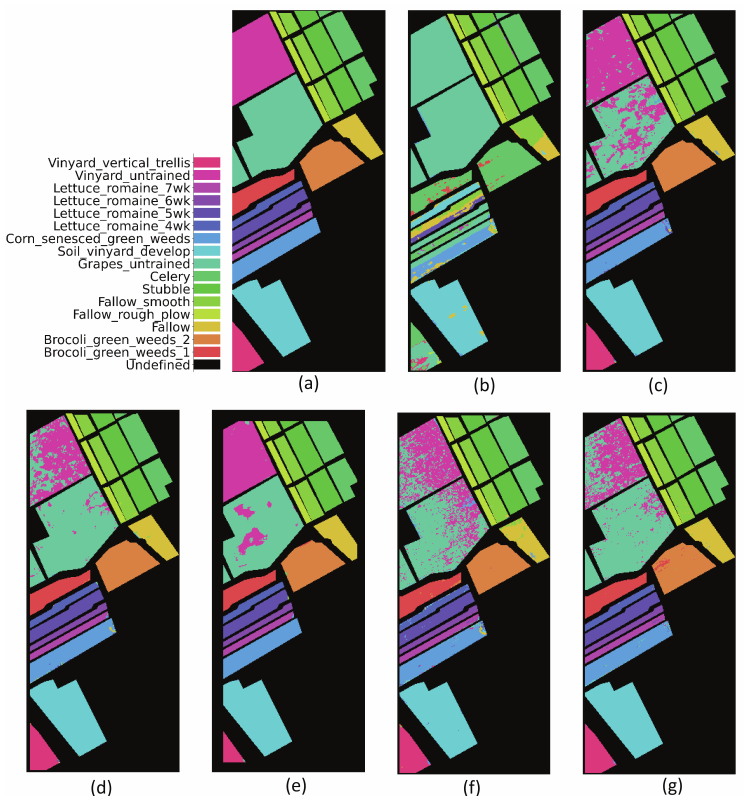
Figure 14. Classification results of Salinas: ( a ) ground truth, ( b ) Luo model, ( c ) Li model, ( d ) Hamida model, ( e ) Chen model, ( f ) Hu model, ( g ) proposed